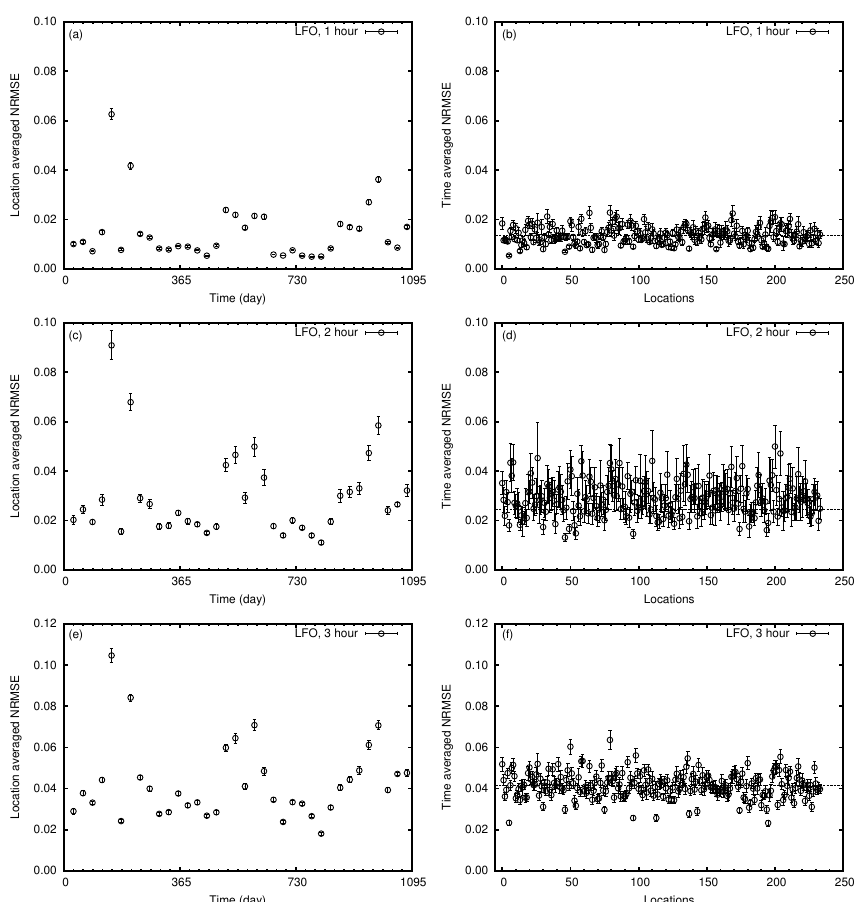
Figure 11. (a) NRMSE of 1h predictions using LFO, for the period from 2004 to 2006 at an interval of 30 days, averaged over 234 locations. (b) NRMSE of 1h predictions using LFO for the 234 locations, calculated at an interval 30 days and averaged over the period from 2004 to 2006. (c) and (e) are location-averaged NRMSE for 2 and 3h predictions respectively. (d) and (f) are time-averaged NRMSE for 2 and 3h predictions respectively. The error bars in the figures are with respect to the standard error of the mean. The horizontal dotted lines in (b) , (d) and (f) represent the mean of the respective time-averaged NRMSE values over the entire set of locations. On the other hand, global models have the advantage of pro- but outside this area, the shape of the model depends heavily viding the structure and properties of the underlying sys- on the chosen function (Hegger et al., 1999). tem as it can yield closed expressions for the full dynamics. 355 Figs. 8(a) and (b) shows typical results of wind speed pre- 360 These models can effectively describe the observed process diction using the above methods, made at a couple of loca- in regions of the space which have been visited by the data, tions for suitable choices of the embedding parameters, and